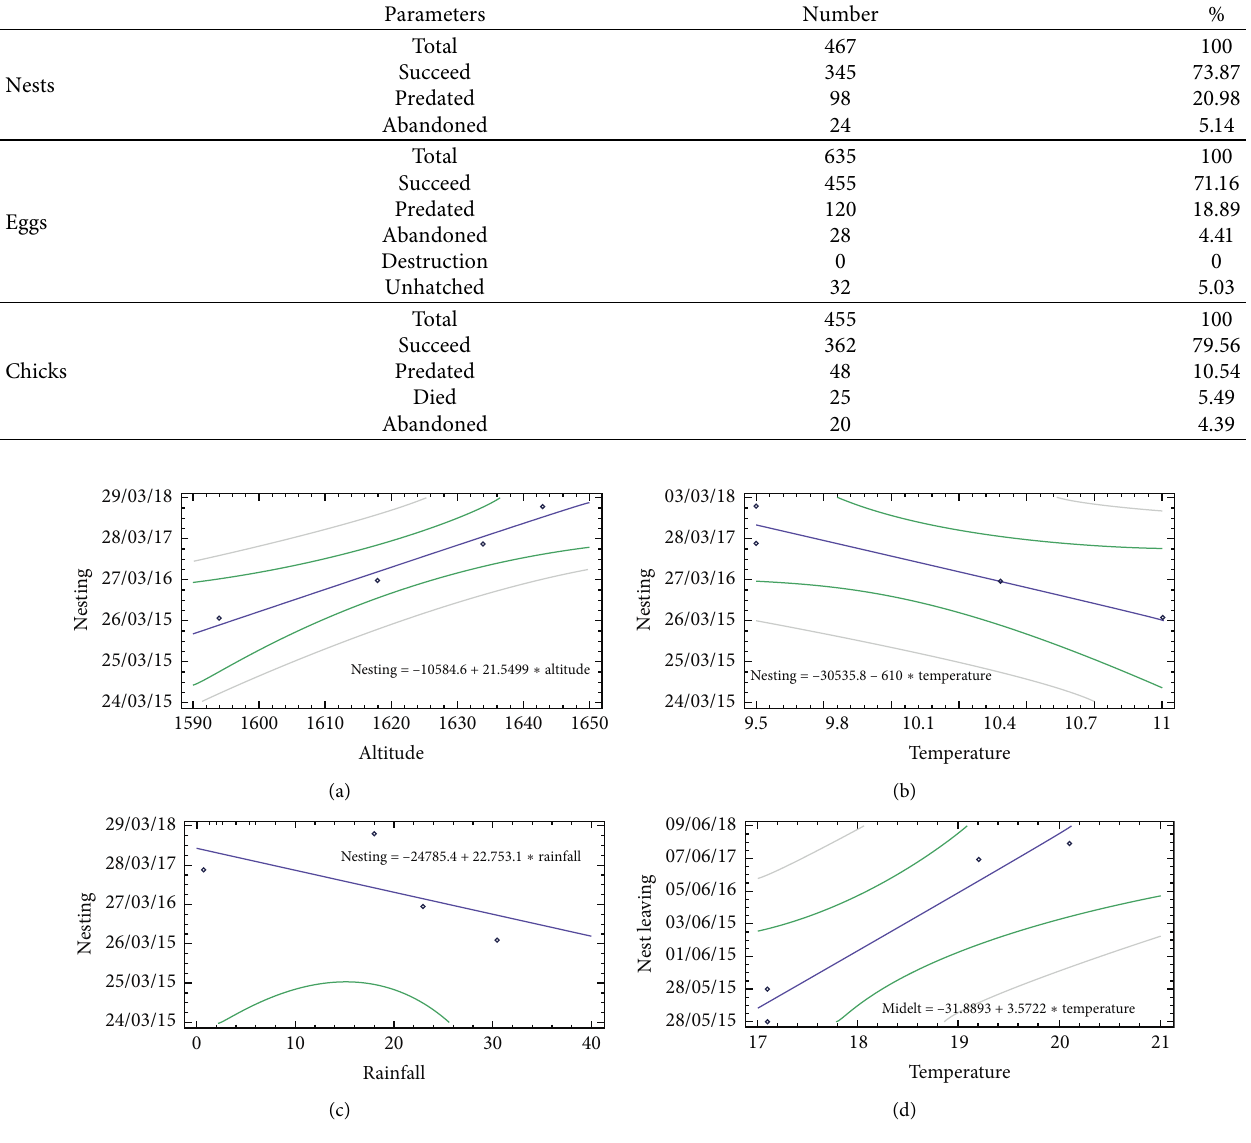
Figure 3: Relationship between the environmental factors and turtle dove chronology at Midelt during 2015 to 2018. (a) Between nesting dates and altitude. (b) Between Nesting dates and temperature. (c) Between nesting dates and rainfall. (d) Between nest leaving dates and temperatures (the lack of fit test is designed to determine whether the selected model is adequate to describe the observed data). Table 2: Models of the relationship between the breeding chronology of turtle doves (dates) and habitat conditions (altitude, temperature, and rainfall) during 2015 to 2018 (the lack of fit test is designed to determine whether the selected model is adequate to describe the observed